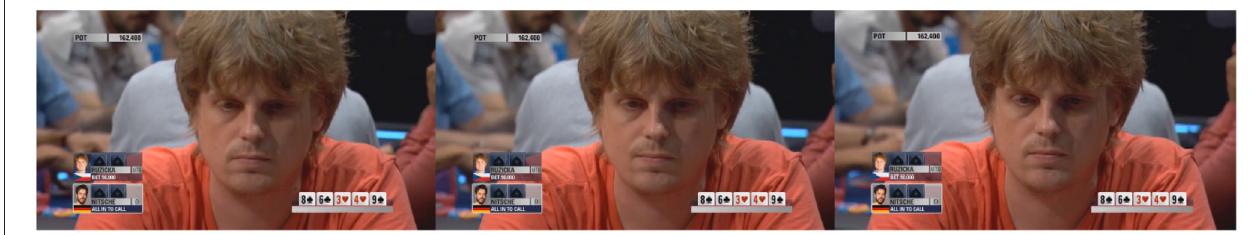
FIGURE 5 | Sample frames from a “Contempt” sequence in MEVIEW that contains micro-movements marked with AU L12. Images reproduced from the database (Husak et al., 2017) under Fair Use.